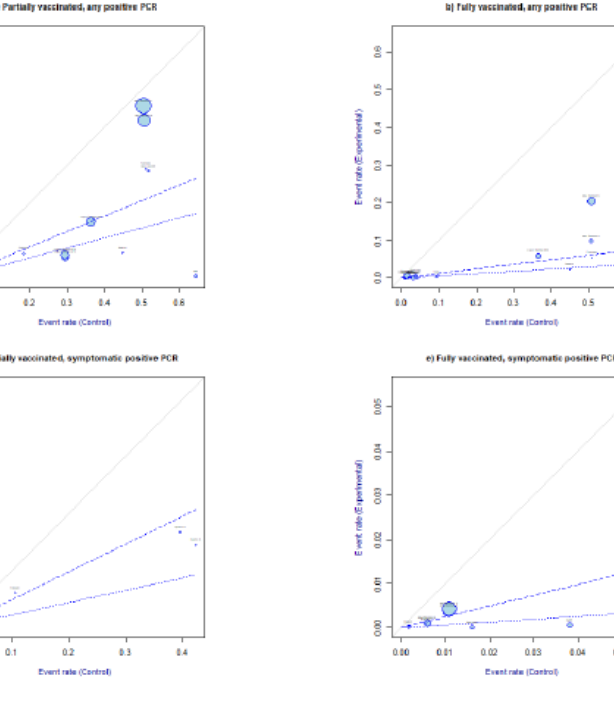
Figure 4. L’Abbè plots. Partially vaccinated, any positive SARS-CoV-2 PCR RR ≥ 14 days from first SARS-CoV-2 dose administration ( a ). Fully vaccinated, any positive PCR RR, ≥ 7 days from full vaccination ( b ). At least one dose, any positive PCR RR ≥ 14 days from vaccination with first dose ( c ). Partially vaccinated, symptomatic positive PCR RR ≥ 14 days from first dose administration ( d ). Fully vaccinated, symptomatic positive SARS-CoV-2 PCR RR ≥ 7 days from full vaccination ( e ). The sizes of the plotted circles are proportional to the precision of the studies. The dashed lines mark the overall estimate of the log risk for RE (light) and FE (bold). The further the circle from the line of no effect, the greater the difference of event rates between intervention and control arms.